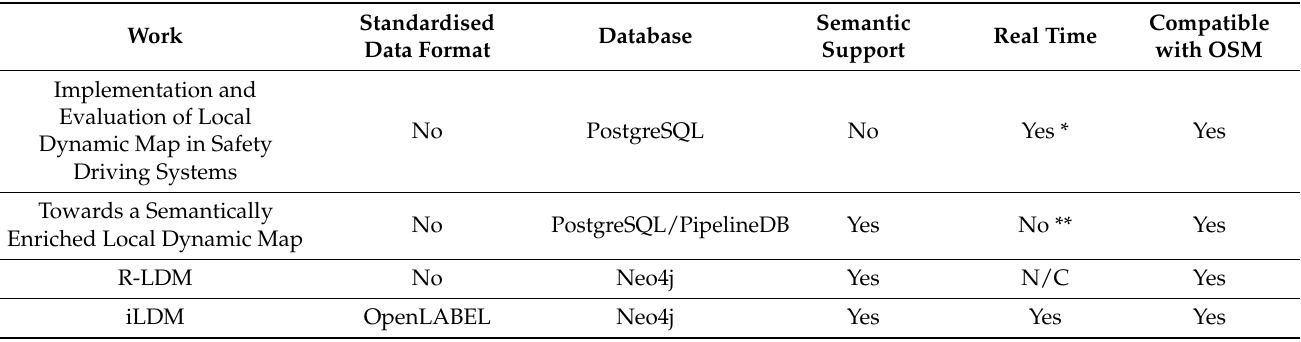
Table 2. Comparison of the iLDM against similar